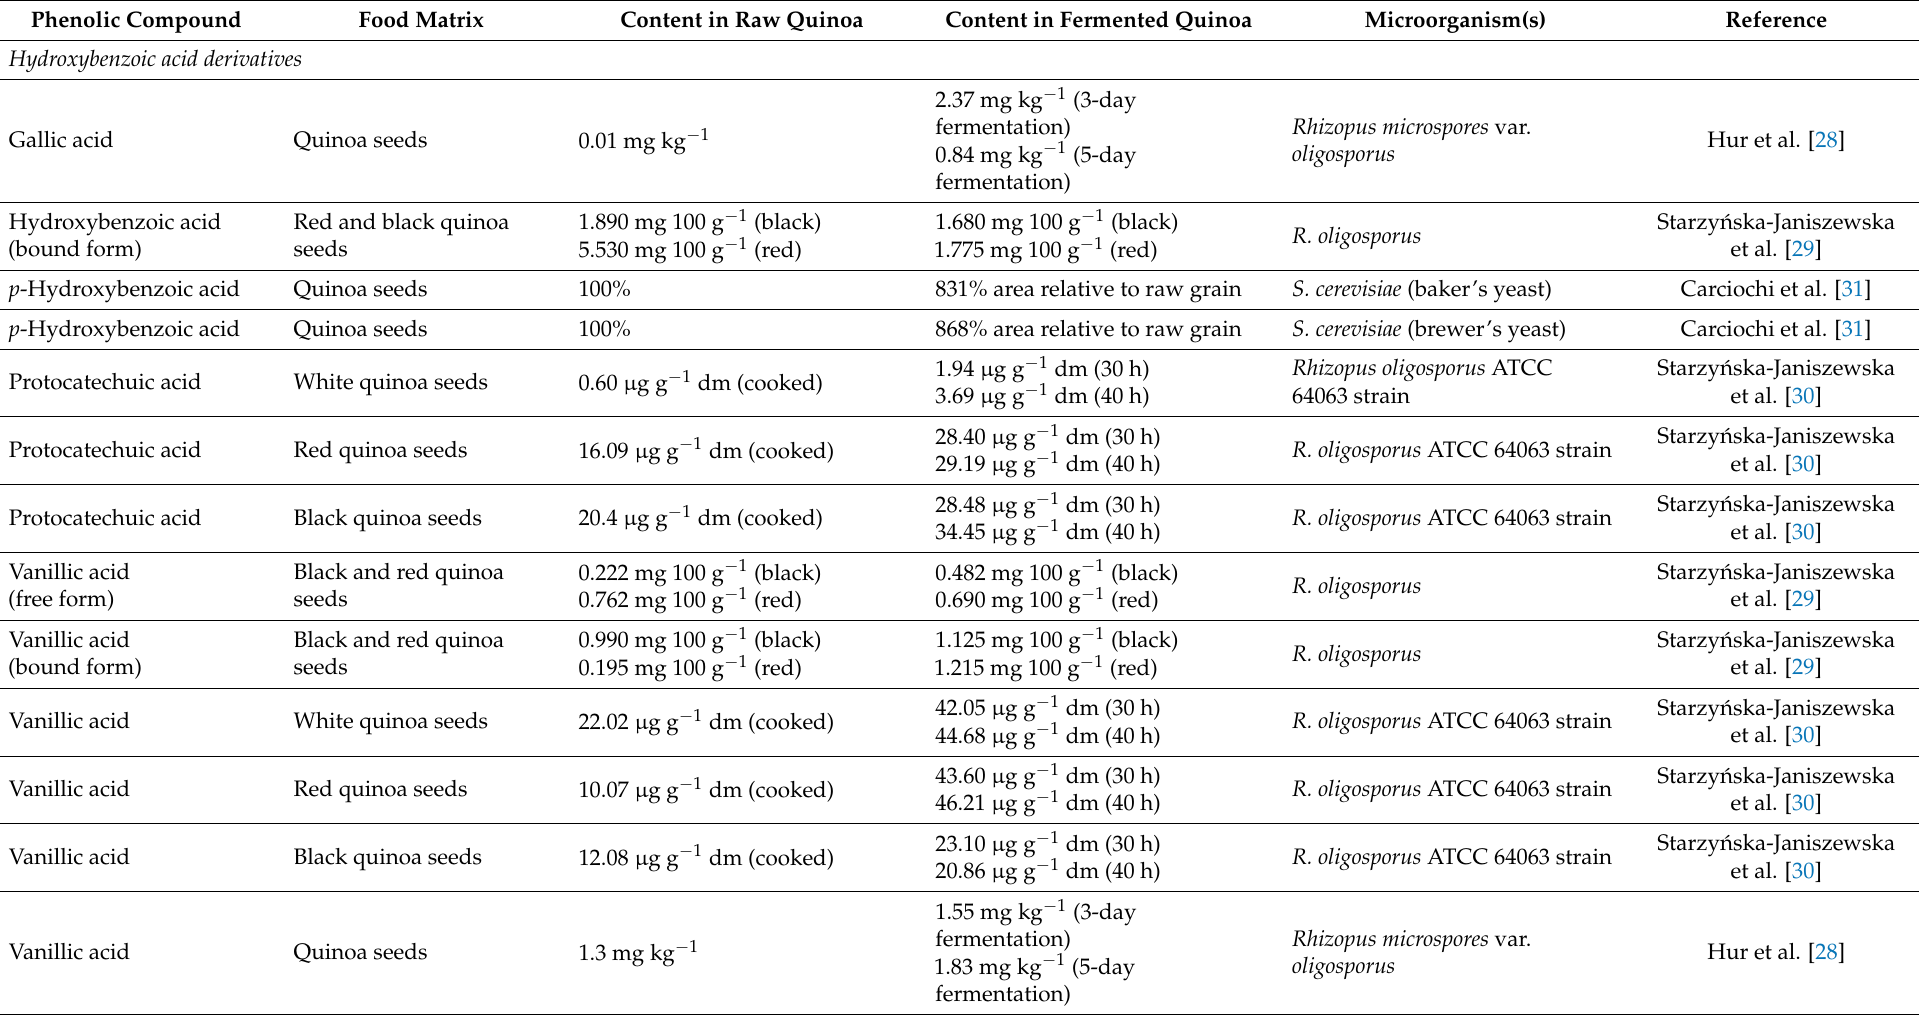
Table 2. Effect of fermentation on phenolic compound profile in quinoa-based fermented